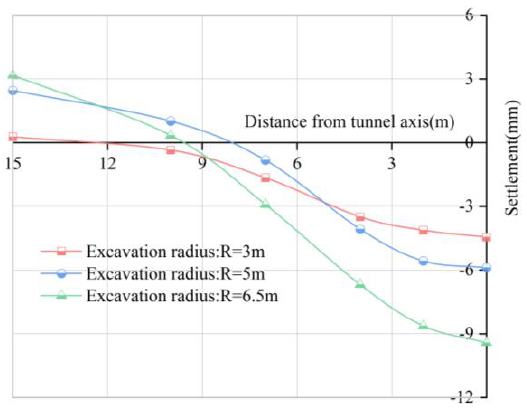
Figure 13. Influence of excavation radius on the lateral deformation of the ground surface.